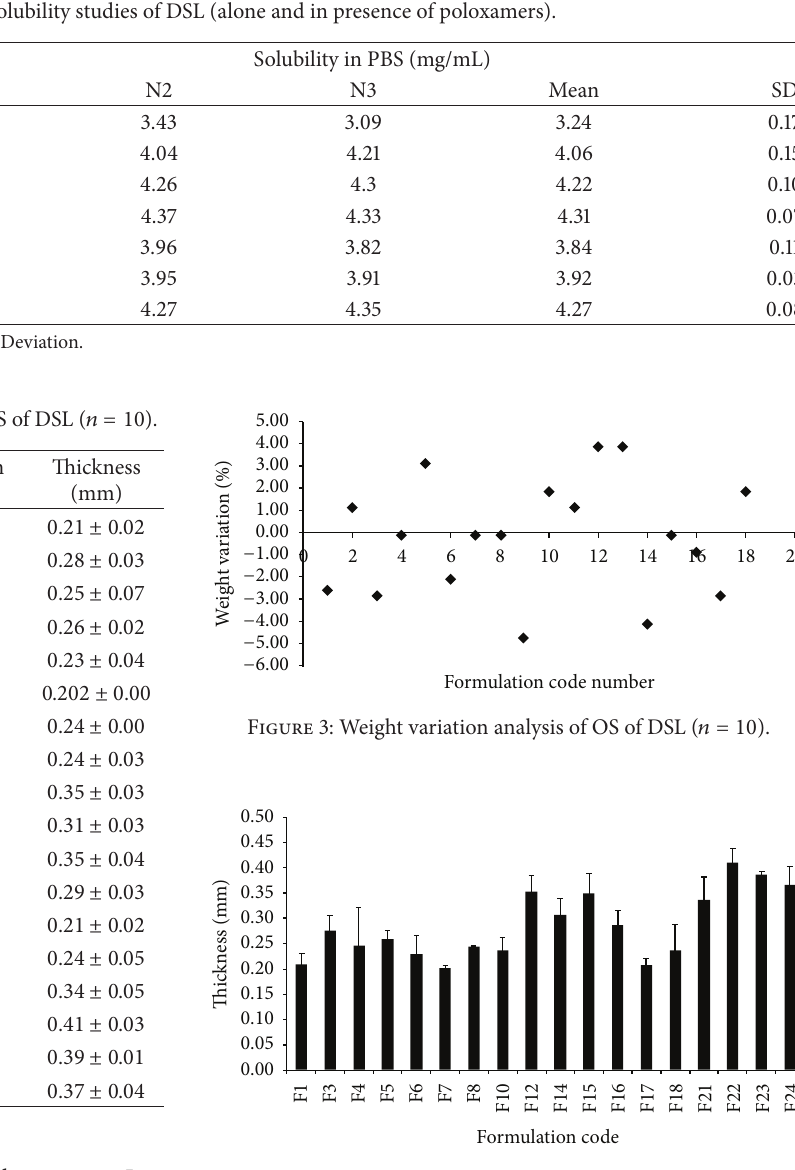
Figure 4: Thickness analysis of OS of DSL ( 𝑛 = 10